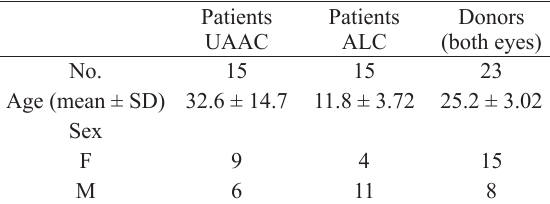
Patients and donors characteristics.